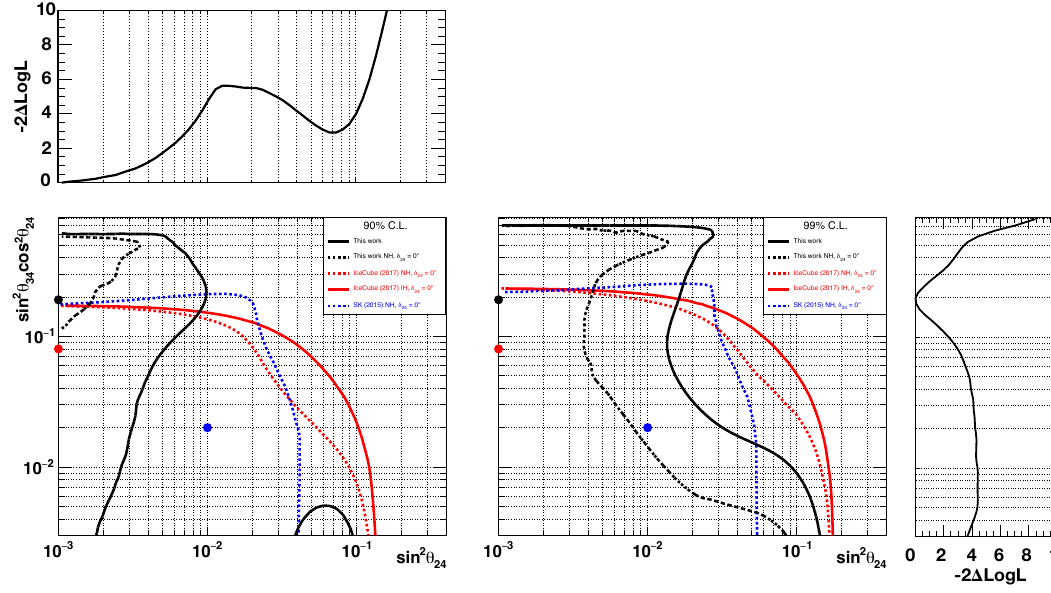
Figure 8 . 90% (left) and 99% (right) CL limits for the 3+1 neutrino model in the parameter plane of j U (cid:22) 4 j 2 = sin 2 (cid:18) 24 and j U (cid:28) 4 j 2 = sin 2 (cid:18) 34 cos 2 (cid:18) 24 obtained in this work (black lines), and compared to the ones published by IceCube/DeepCore [16] (red) and Super-Kamiokande [15] (blue). The dashed lines are obtained for NH and (cid:14) 24 = 0 (cid:14) while the solid lines are for an unconstrained (cid:14) 24 (this work) or for IH and (cid:14) 24 = 0 (cid:14) (IceCube/Deepcore) respectively. The coulored markers indicate the best-(cid:12)t values for each experiment. The 1D projections after pro(cid:12)ling over the other variable are also shown for the result of this